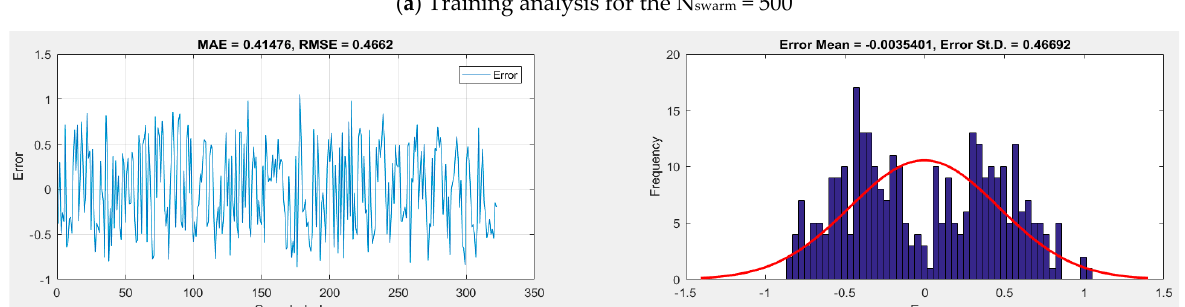
Figure 12. BSA-MLP Training and testing analysis.